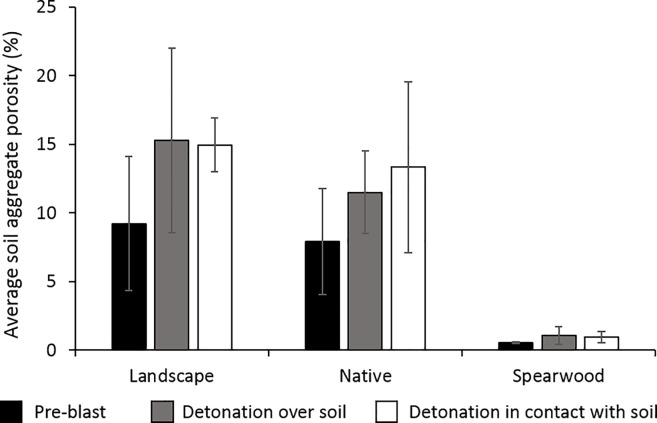
Calculated average porosities from the pre- and post-blast landscape, native and Spearwood soil aggregates.Error bars show standard deviations between three measurements.